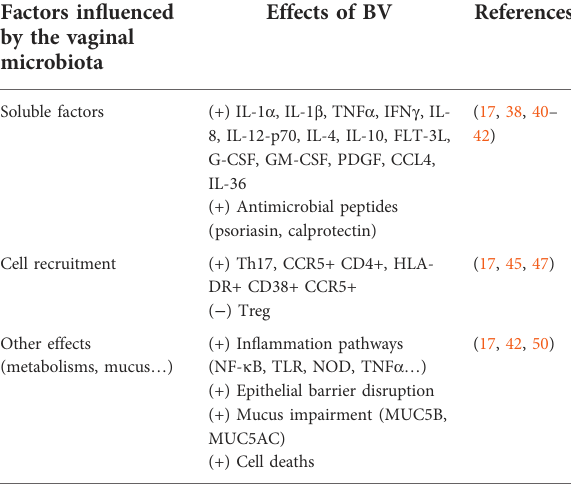
TABLE 1 Effects of bacterial vaginosis on the immune